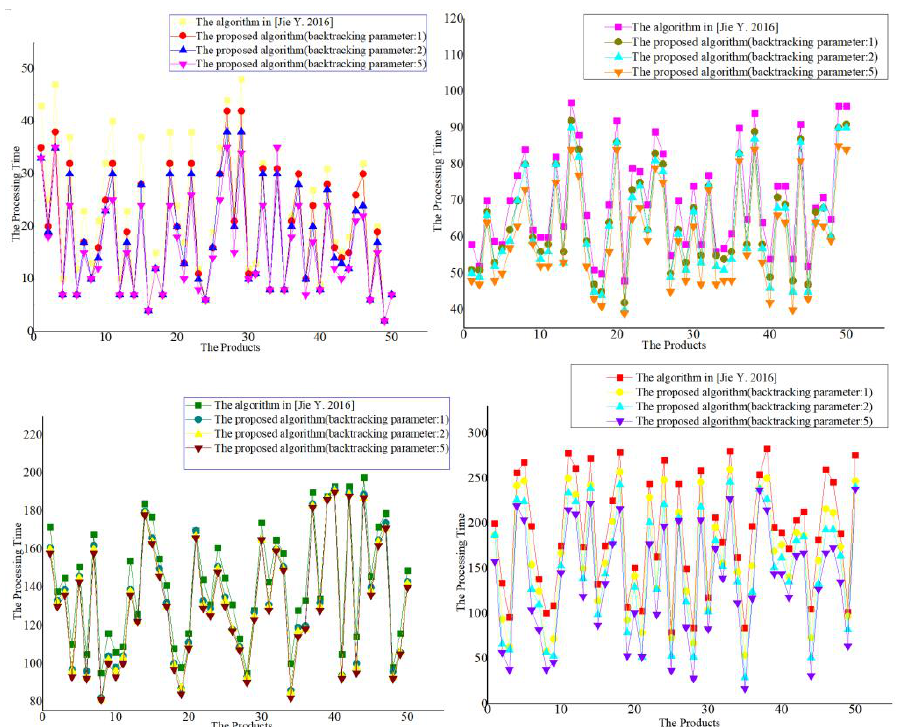
Figure 12. Comparison between the proposed algorithm and Ref. [16].